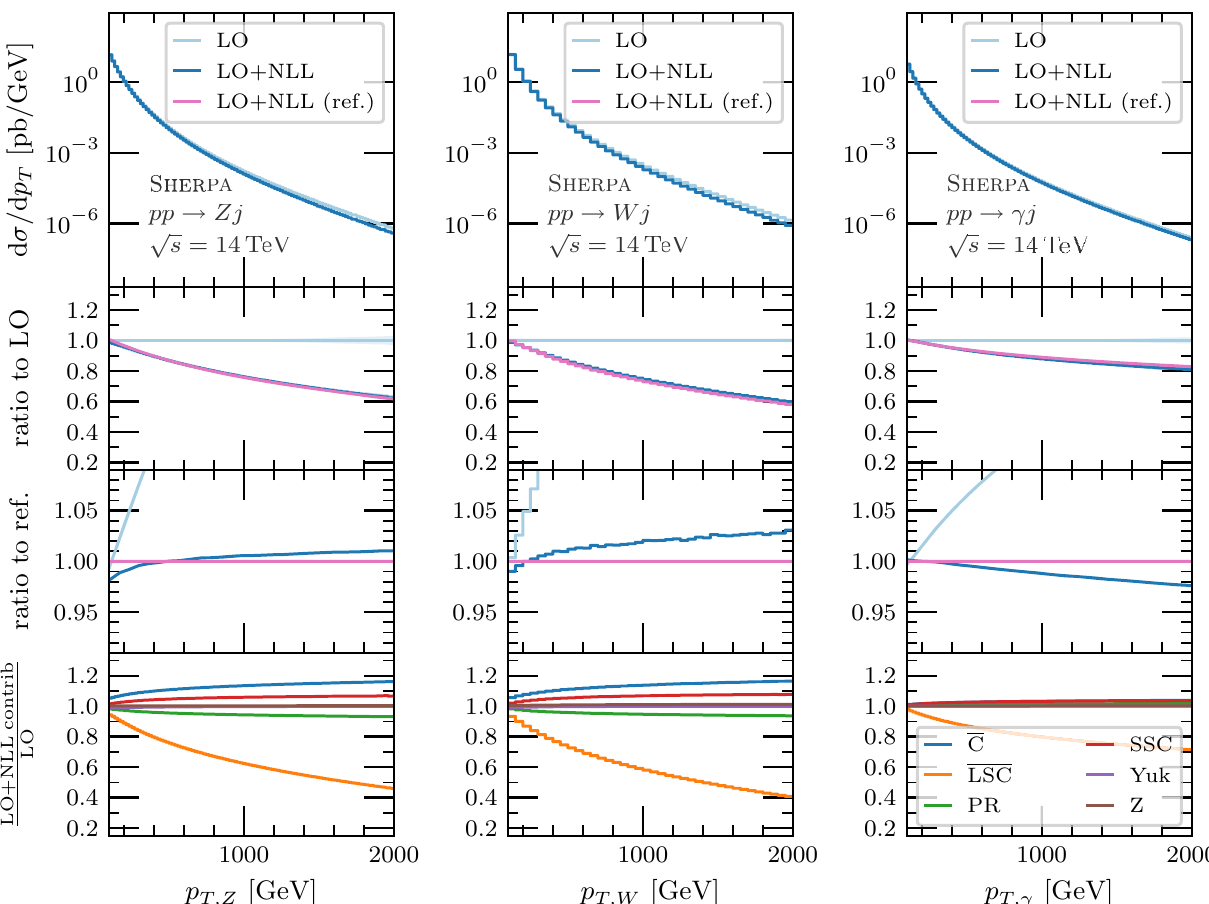
Fig. 4 The transverse momentum of the vector boson in V j produc- tion for V = W + , Z ,γ . The baseline LO calculations are compared with the results of our LO+NLL calculation and reference LO+NLL